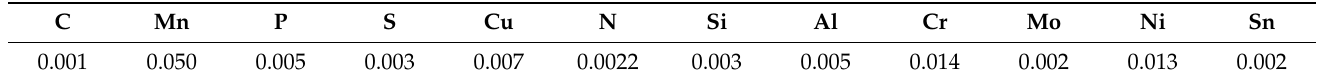
Table 1. Chemical composition of Armco iron (%).